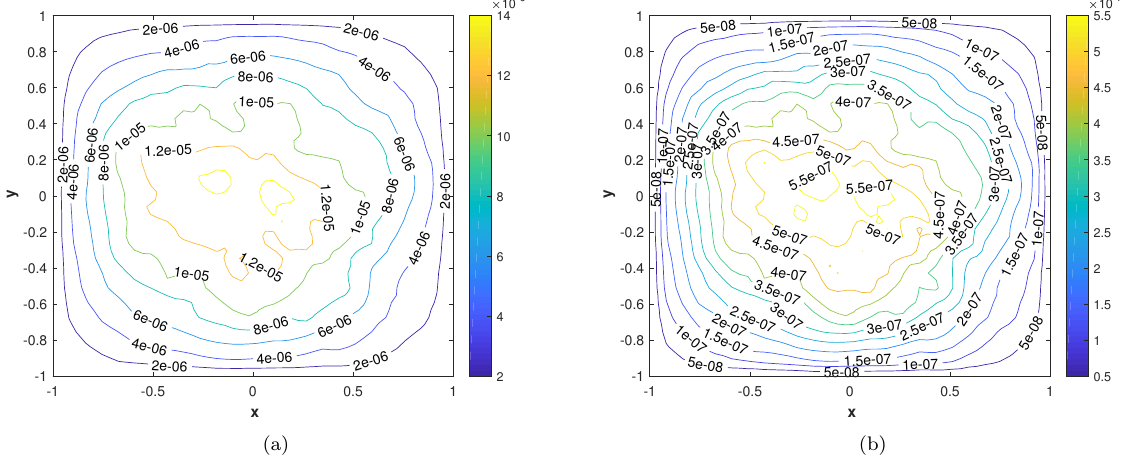
Figure 15: (a) Contour plot of Ab Error at time level T = 1 . (b) Contour plot Rms Error at time level T = 1 . Figure 15. ( a ) Contour plot of Ab Error at time level T = 1. ( b ) Contour plot Rms Error at time level T =